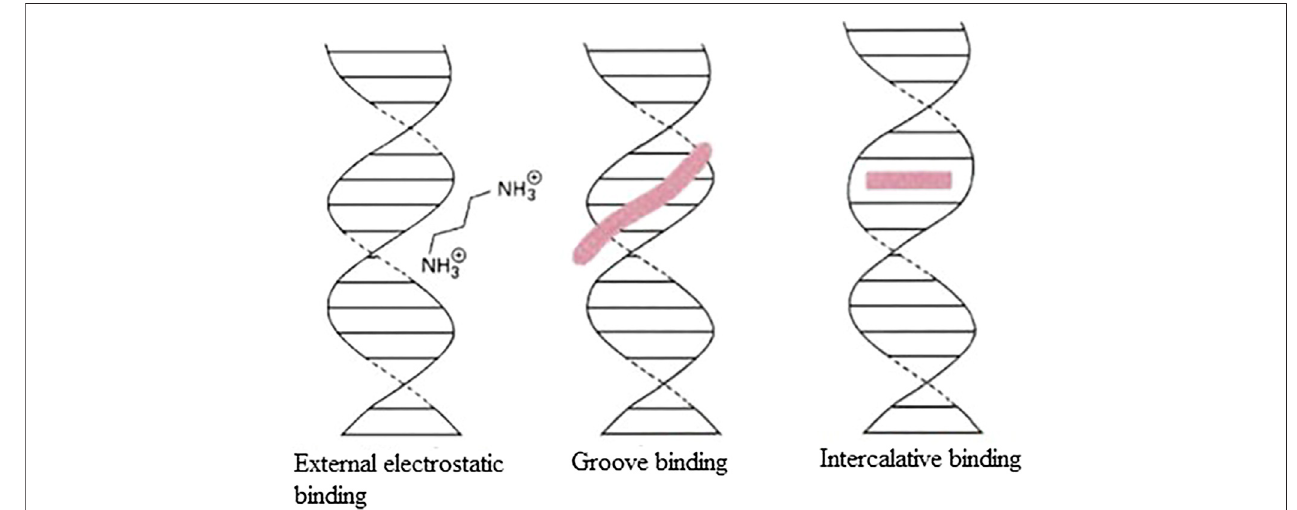
FIGURE 2 | Three types of reversible DNA binders.